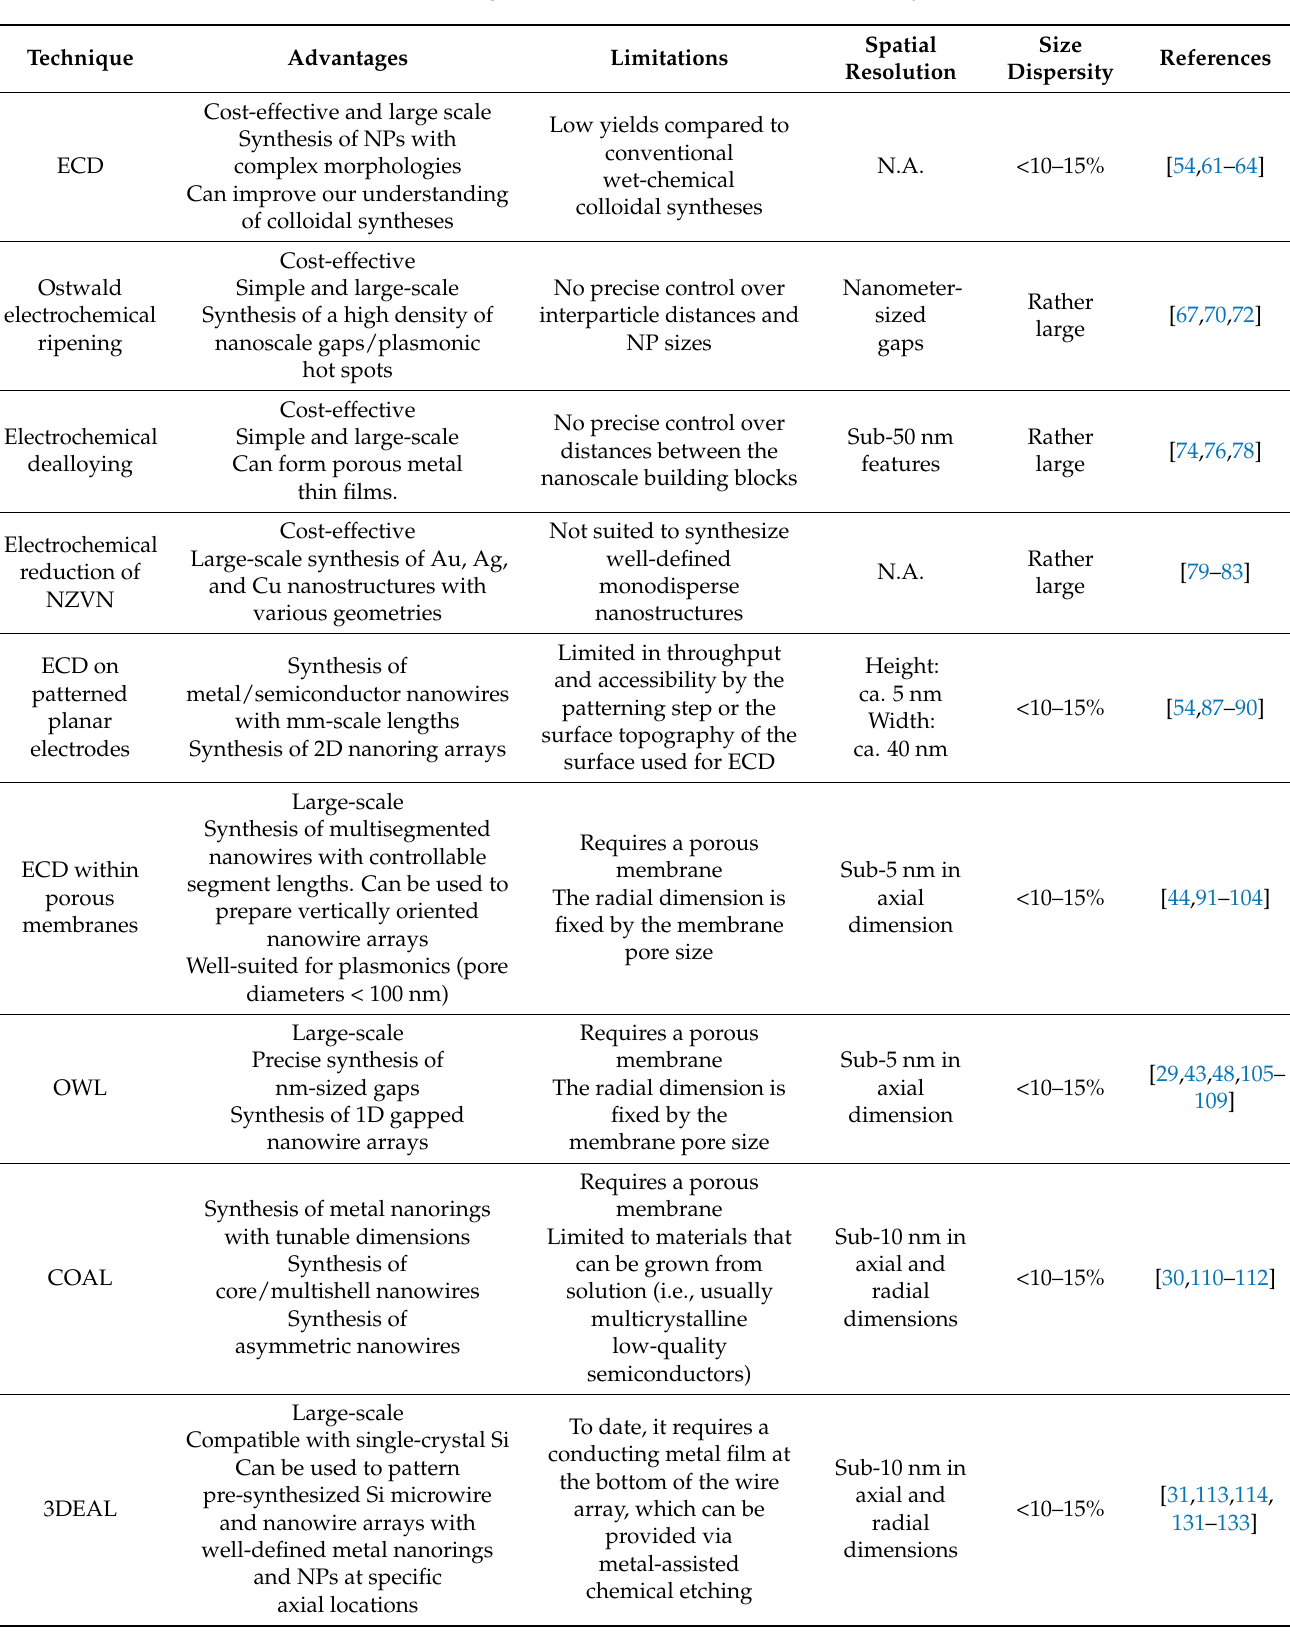
Table 1. Advantages and limitations of the electrochemical syntheses discussed in this